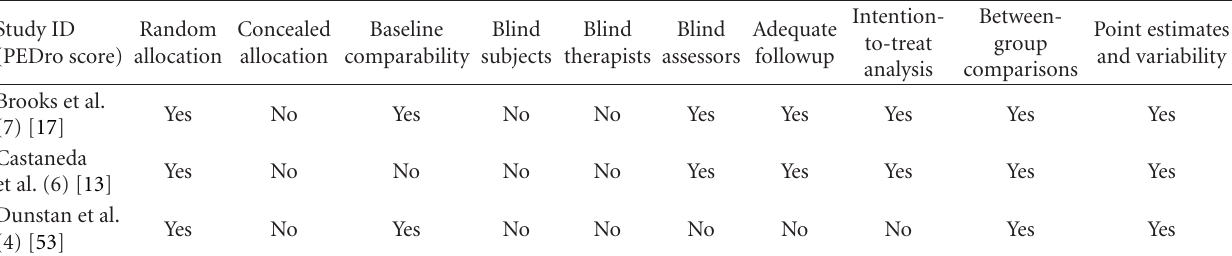
Table 5: PEDro rating details.